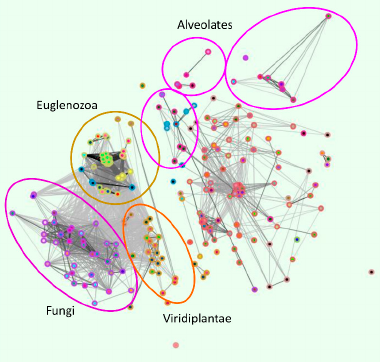
Figure 1. Conserved plasma membrane importer Cluster (OG5_126707). Clustering performed using OrthoMCL. Orthologues of C. albicans Zrt2 are conserved within eukaryotes. All characterised members of the clusters are implicated in plasma membrane zinc import.